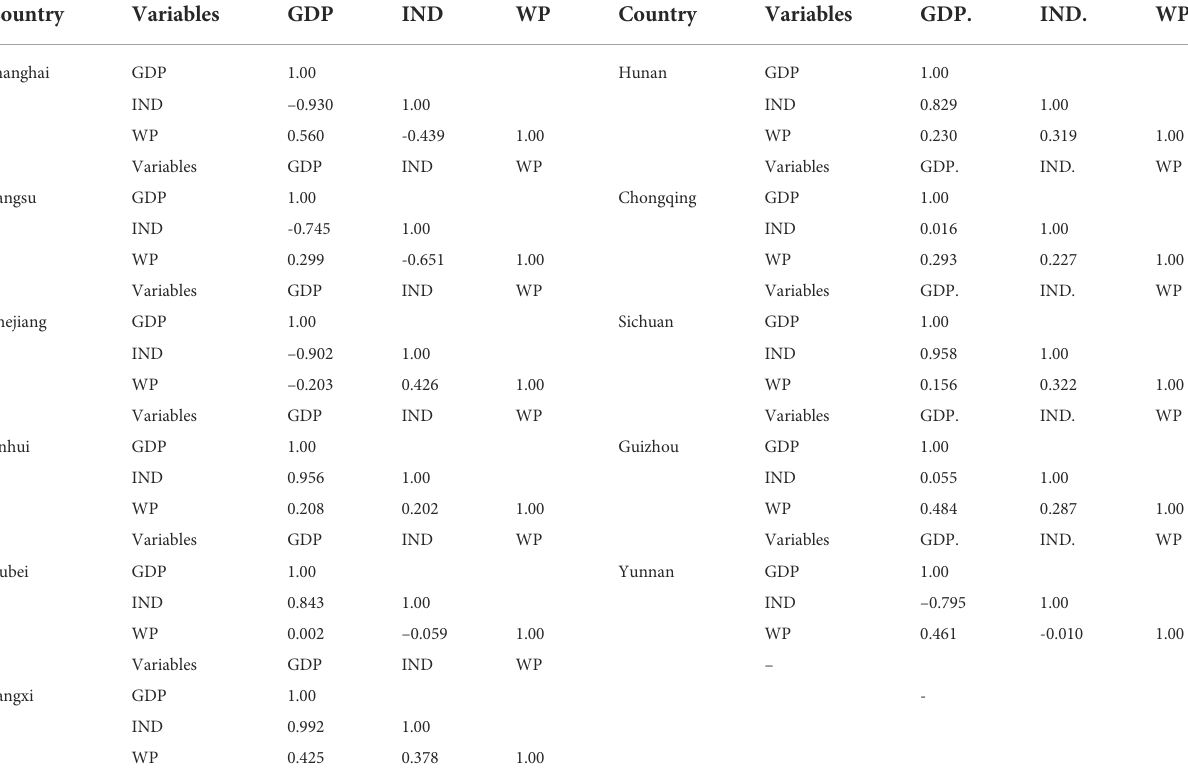
TABLE 2 Correlation.